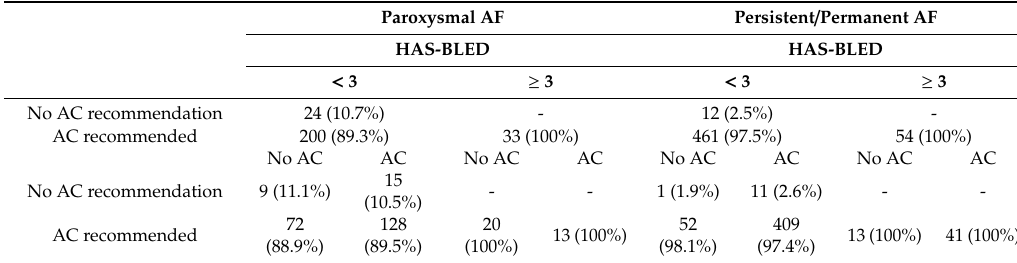
Table 3. AC treatment regarding the type of AF, HASBLED score and CHA2DS2-VASc score.